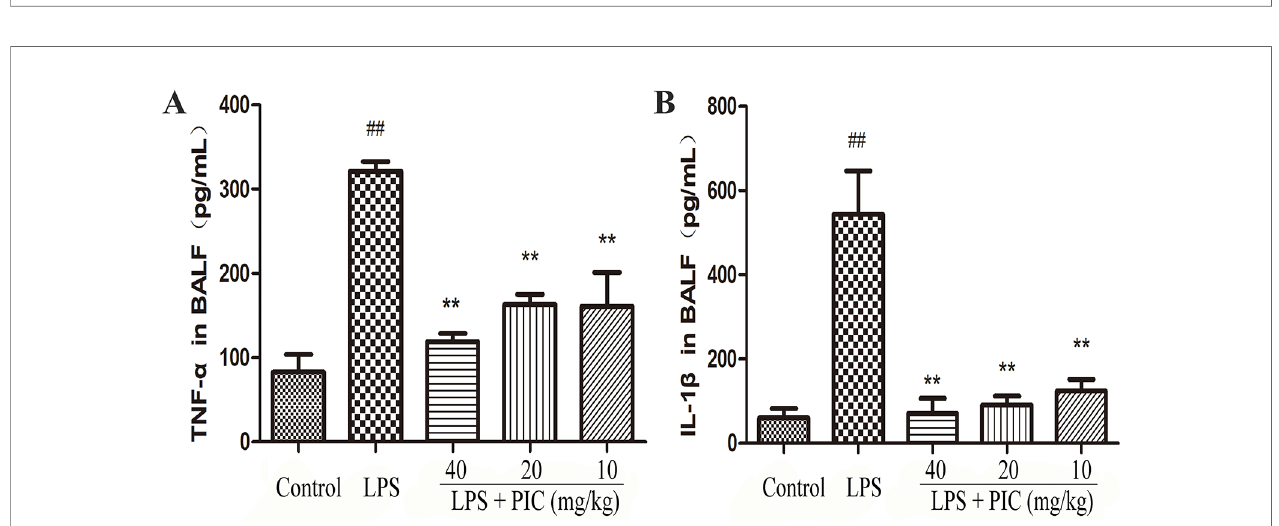
FIGURE 5 | The production of pro-in fl ammatory cytokines in bronchoalveolar lavage fl uid (BALF). After collecting the BALF, the levels of pro-in fl ammatory cytokines (A) tumor necrosis factor (TNF)- a and (B) interleukin (IL)-1 b were detected by ELISA kits according to the manufacturer's instructions. ## p < 0.01 is signi fi cantly different from the control group; ** p < 0.01 are signi fi cantly different from the lipopolysaccharide (LPS)